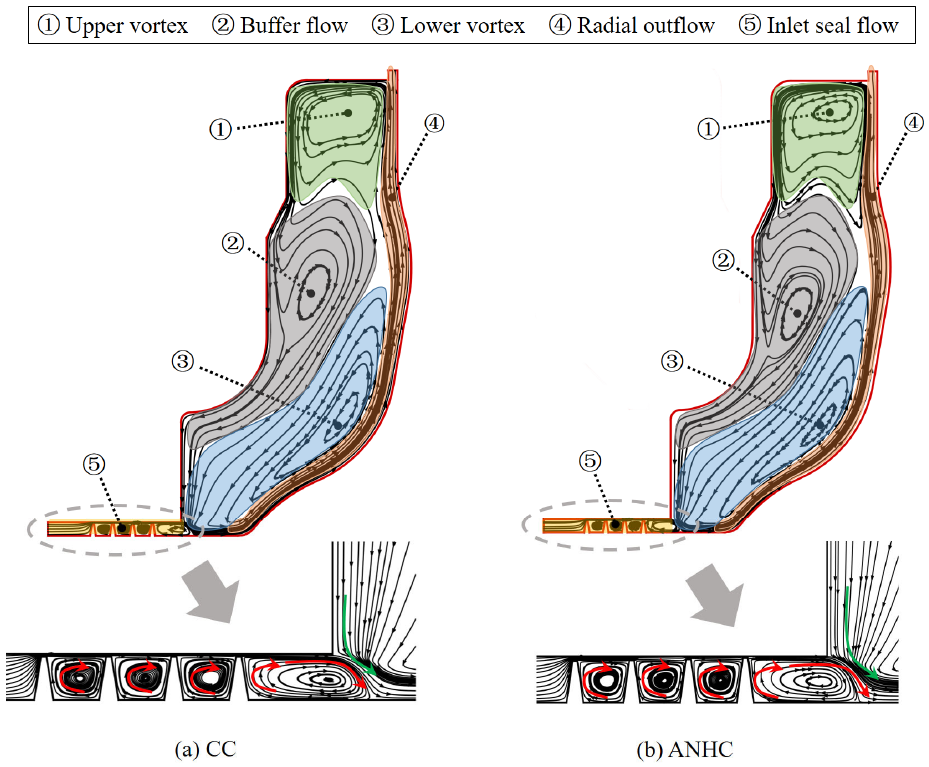
Figure 15. Flow structure (cruise